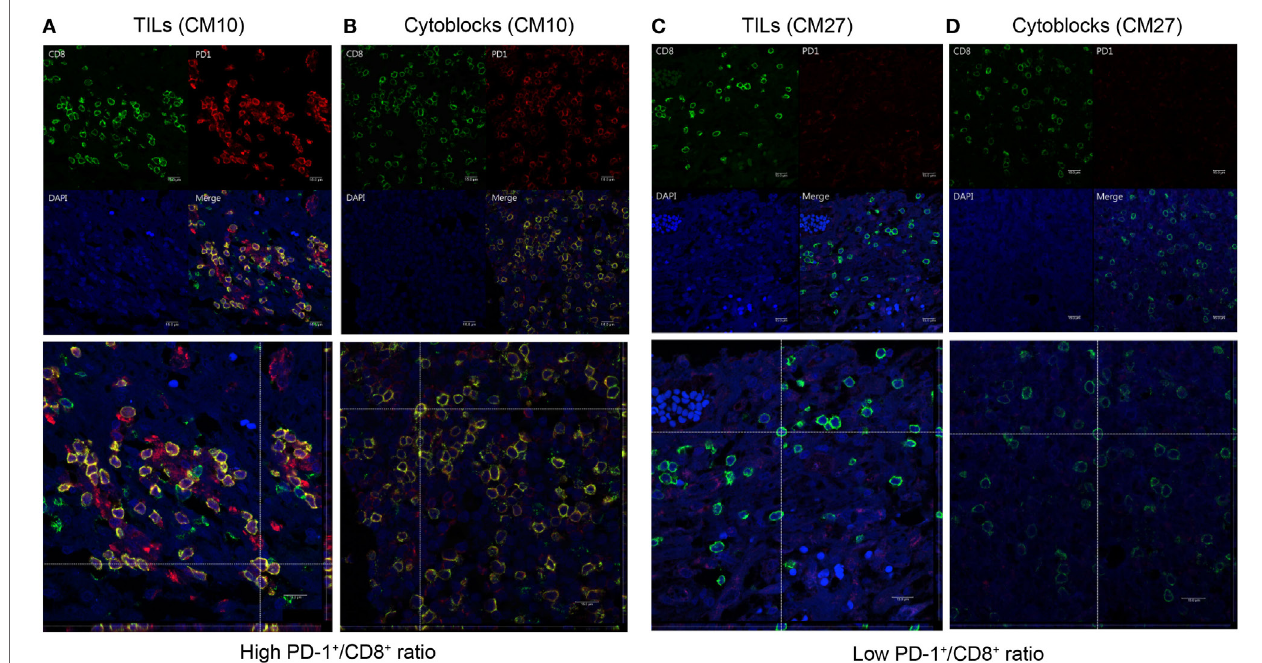
FigUre 9 | Co-expression of programed death 1 (PD-1) and CD8 in PD-1-positive and CD8-positive tumor-infiltrating lymphocytes and peripheral blood mononuclear cells (PBMCs). Paired GBM tissue sections and PBMC cytoblocks from a representative patient with a high PD-1 + /CD8 + ratio were selected for immunofluorescence (IF) analysis of PD-1 and CD8 co-expression. CD8 and PD-1 expression in the TIL of GBM tissue [ (a) , upper panel] and reconstruction of single slices of the xz and the yz planes in the z -axis stacked image [ (a) , lower panel]. CD8 and PD-1 expression in PBMCs derived from the same patient [ (B) , upper panel] and reconstruction of the same immunofluorescent slide [ (B) , lower panel]. Paired GBM tissue sections and PBMC cytoblocks from a representative patient with a low PD-1 + /CD8 + ratio were selected for IF analysis of PD-1 and CD8 co-expression. CD8 and PD-1 expression in the TIL of GBM tissue [ (c) , upper panel] and reconstruction of single slices of the xz and yz planes in the z -axis stacked image [ (c) , lower panel]. CD8 and PD-1 expression in PBMCs derived from the same patient [ (D) , upper panel] and reconstruction of the same immunofluorescent slide [ (D) , lower